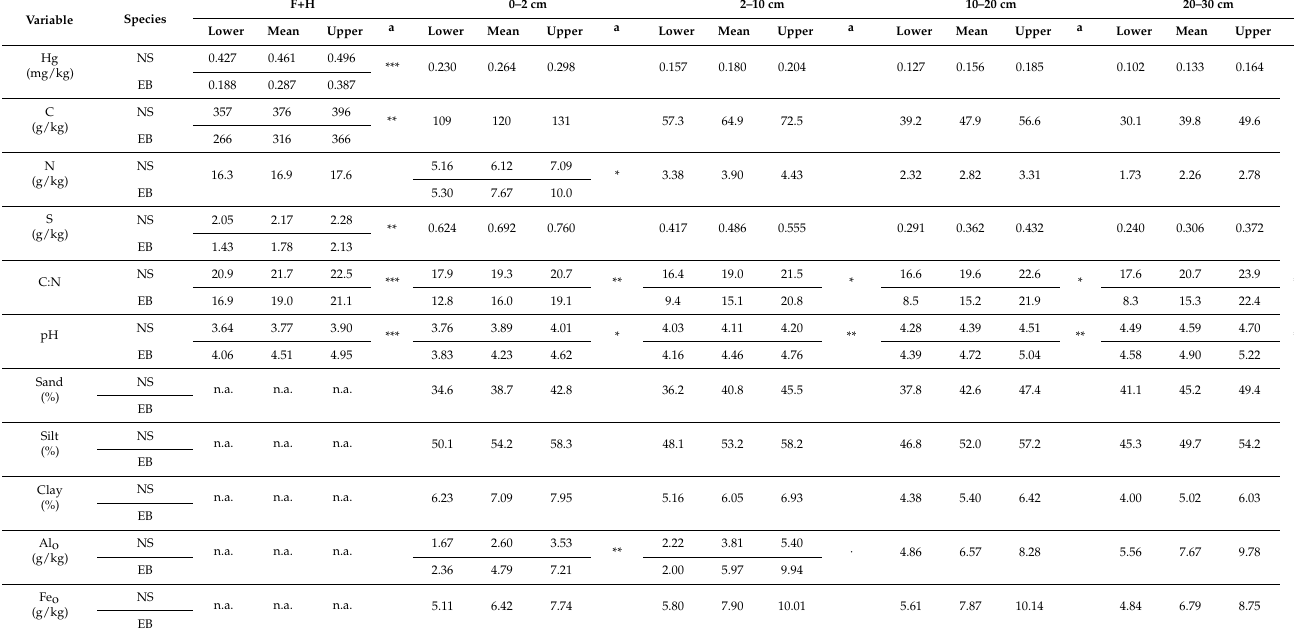
Table A1. Soil characteristics at different sampling depths depending on the tree species; mean estimates of the mixed model (lower and upper limits of the mean 95% confidence interval), with forest type and site as fixed and random effects, respectively; were not significant, the fixed effects were replaced by a constant (without considering the forest type); NS = Norway spruce; EB = European beech; n.a. not